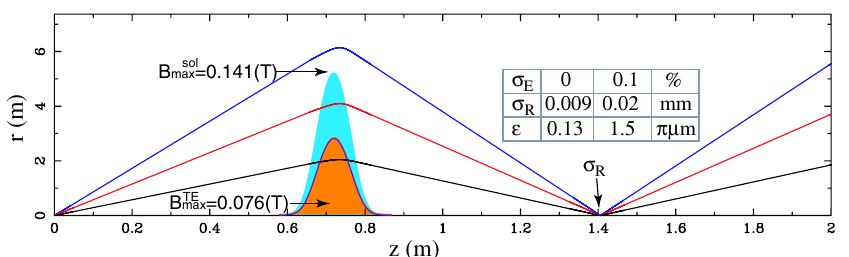
is rms energy spread E